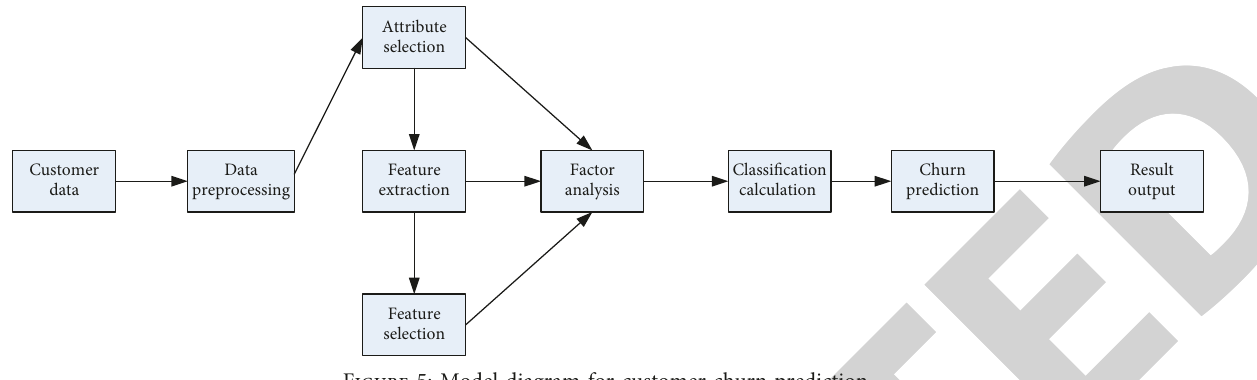
Figure 5: Model diagram for customer churn